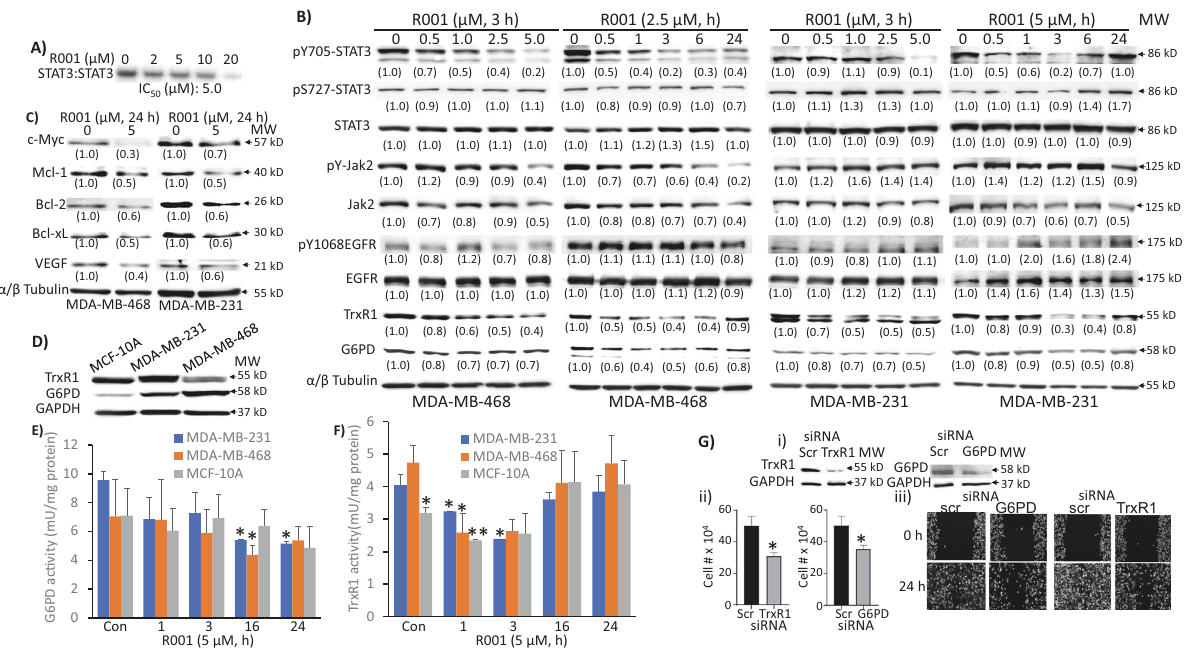
Fig. 2 Inhibitory effects of R001 on STAT3 signaling and the expression and activities of glucose-6-phosphate dehydrogenase and thioredoxin reductase, and the effects of G6PD or TrxR1 knockdown on cell growth and migration in breast cancer models. A Nuclear extracts of equal total protein containing activated STAT3 prepared from NIH3T3/v-Src fi broblasts were pre-incubated with 0 – 20 µM R001 for 30 min at room temperature prior to incubating with the radiolabeled hSIE probe that binds STAT3 and performing EMSA analysis; bands corresponding to STAT3:DNA complexes in gel were quanti fi ed using ImageJ, plotted against concentration from which the IC 50 value was derived; B – D immunoblotting analysis of whole-cell lysates of equal total protein prepared from the MDA-MB-231, MDA-MB-468, or MCF-10A cells B treated with or without R001 at 0.5 – 5 µM for 3 h or with a single concentration, 2.5 µM or 5 µM for 0 – 24 h, or C treated with or without 5 µM for 24 h, or D untreated and probing for pY705-STAT3, STAT3, pS727-STAT3, pY-Jak2, Jak2, pY1068EGFR, EGFR, TrxR1, c-Myc, Mcl-1, Bcl-2, Bcl-xL, VEGF, G6PD, tubulin, or GAPDH; protein bands were scanned and quanti fi ed using ImageJ and expressed as a fraction of control, which are presented in parentheses; E , F MCF-10A, MDA-MB-231 and MDA-MB-468 lines in culture were untreated (Con) or treated once with 5 µM R001 for the indicated times and cells were processed and assayed for E G6PD or F TrxR1 activity, which is plotted against treatment time; n = 3 ( G ) MDA-MB-231 cells transfected for 24 h with scrambled (scr) or pooled speci fi c siRNA to knockdown (i) G6PD or TrxR1, and the effects on (ii) viable cell numbers or (iii) cell migration into denuded area; n = 3. Positions of proteins or DNA-bound STAT3 in gel are labeled; control lane (0, Con, scr) represents whole-cell lysates prepared from 0.1% DMSO-treated cells, nuclear extracts pre-treated with 10% DMSO, or cells transfected with scrambled siRNA. Values, mean ± S.D. Data are representative of 2 – 3 independent determinations. * p < 0.05 and ** p < 0.01; MW molecular were largely unaffected (Fig. 2B, pS727-STAT3, pY1068EGFR and pY-Jak2). Phospho-Tyr STAT3 is inhibited by R001 at 0.5 µM and as